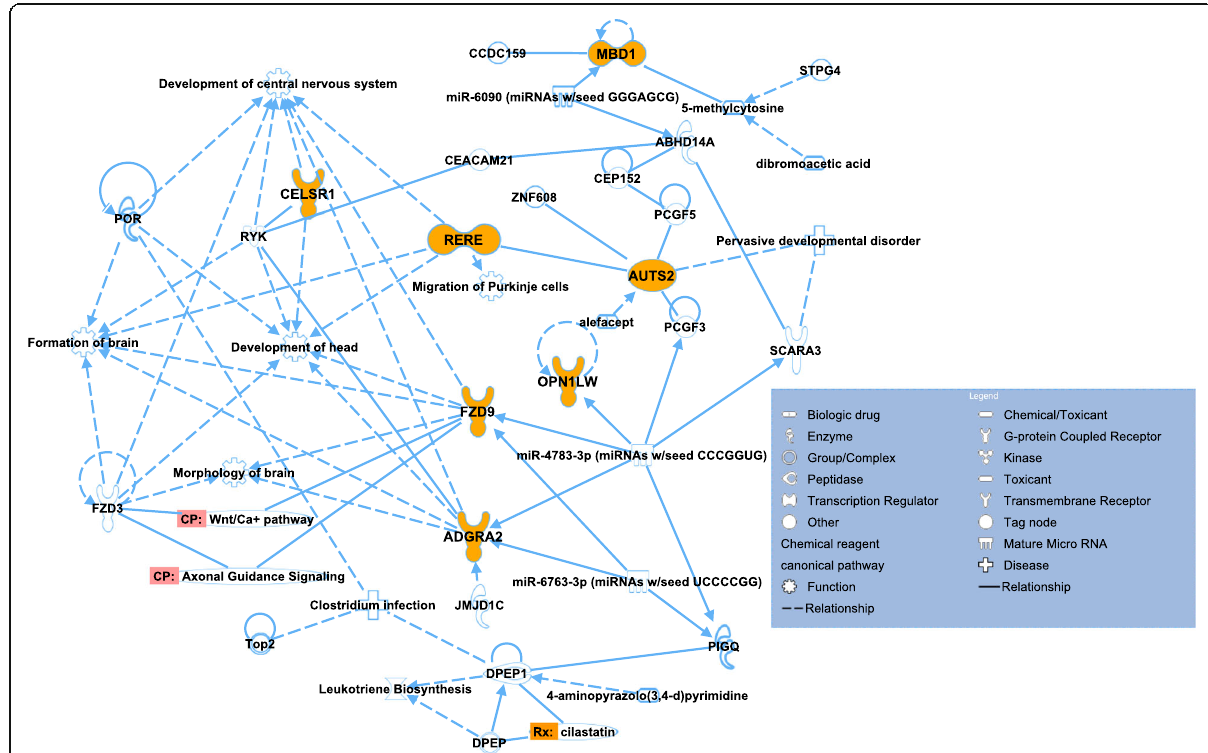
Fig. 3 Enriched autism-genes in risk homozygous haplotype blocks with seven gene- clusters impairing relevant